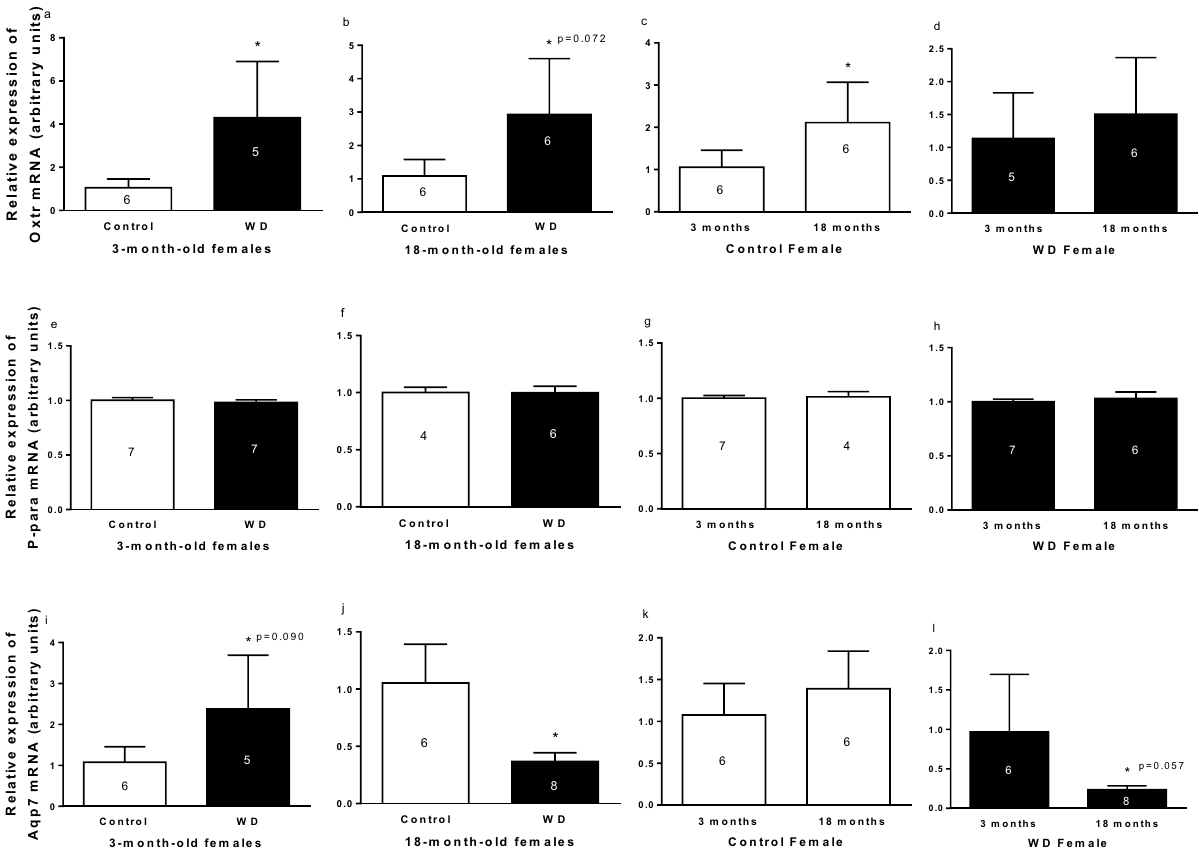
Figure 6. Relative expression of Oxtr ( a – d ), Ppara ( e – h ) , and Aqp7 ( i – l ) mRNA in R-WAT of 3- and 18-month- old control and with water deprivation (WD) female rats. Comparison by hydration condition ( a and b ; e and f ; i and j ), age ( c and d ; g and h ; k and l ). Data are presented as means (SD), *p < 0.05 with respect to control ( a , b , i , and j ), 3-month-old ( c and l ). Student’s unpaired t-test. The n for each group is inside or above the